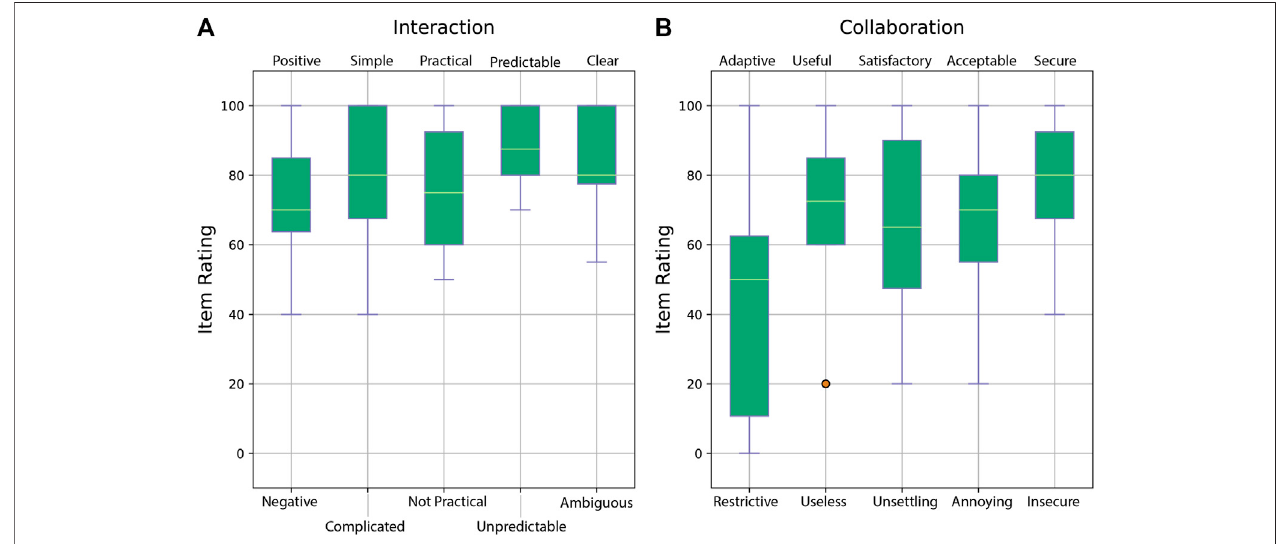
FIGURE6| ResultsofthePeRDITAquestionnaireforthe Interaction and Collaboration dimensions. (PanelA) showstheitemratingsformingpartofthe Interaction dimension, and (Panel B) shows the item ratings for the Collaboration dimension.